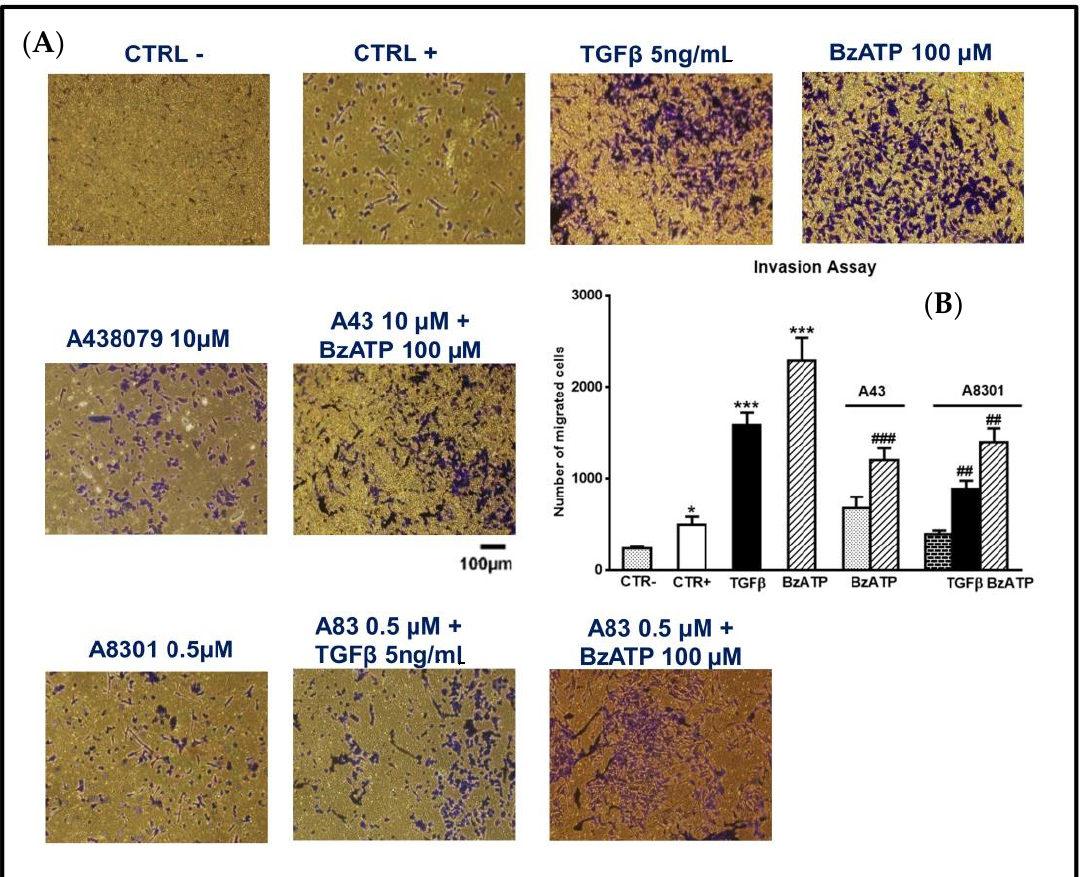
Figure 8. E ff ect of TGF β 1 and BzATP on GSC invasiveness evaluated by transwell migration assay. ( A ) GSCs, plated in the upper surface of a membrane inserted into a suitable plate, were incubated in the usual culture medium alone (CTR-) or in the presence of TGF β 1 or BzATP. In some experiments cells were pretreated with A438079 (A43), a P2X7R antagonist, or A8301 (A83), inhibitor of TGF β type I receptors, which were added alone and 1 or 2 h, respectively, prior to the further pharmacological treatments. In another set of cells, a high percentage of serum (10%), usually acting as an attractant for cells, was added to the medium and cells were indicated as CTR + . The cells were allowed to migrate to the lower chamber for 24 h. The membranes were then removed and the cells, fixed and stained using crystal violet, were counted under a light microscope (at an average of five semirandom non-overlapping fields at 10x magnification). The images reported in the figure (scale bar = 100 µ m) are related to GSCs #2 and are representative of three independent experiments carried out for each cell type, giving similar results. ( B ) Accordingly, values in the histograms are the mean ± SEM of these independent experiments and have been analyzed by one-way ANOVA and Dunnett’s post hoc test * p < 0.05, *** p < 0.001 vs. control (CTR + ); ## p < 0.01; ### p < 0.001 vs. cells treated with TGF β 1 or BzATP.